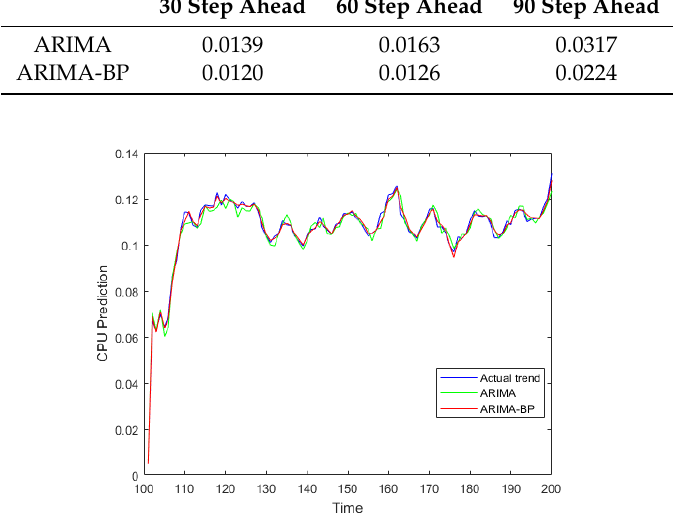
Figure 3. Prediction on CPU usage by ARIMA and